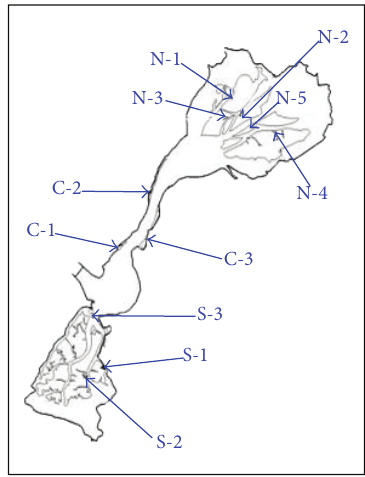
Figure 1: Map of Humboldt Bay showing plot locations. Eelgrass beds are outlined in